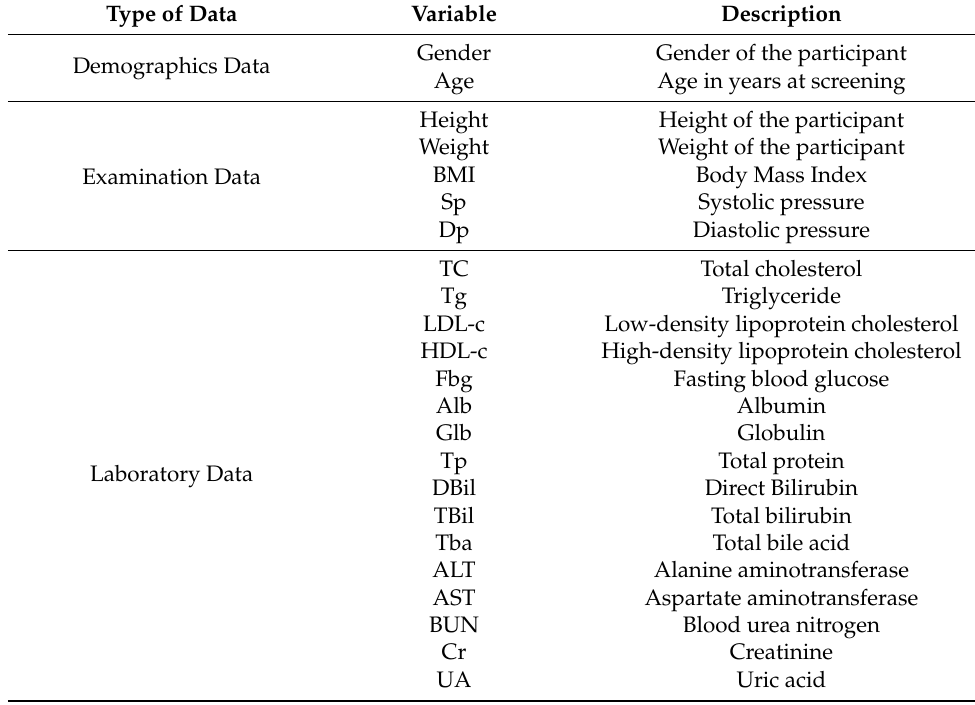
Table 1. Detailed variable